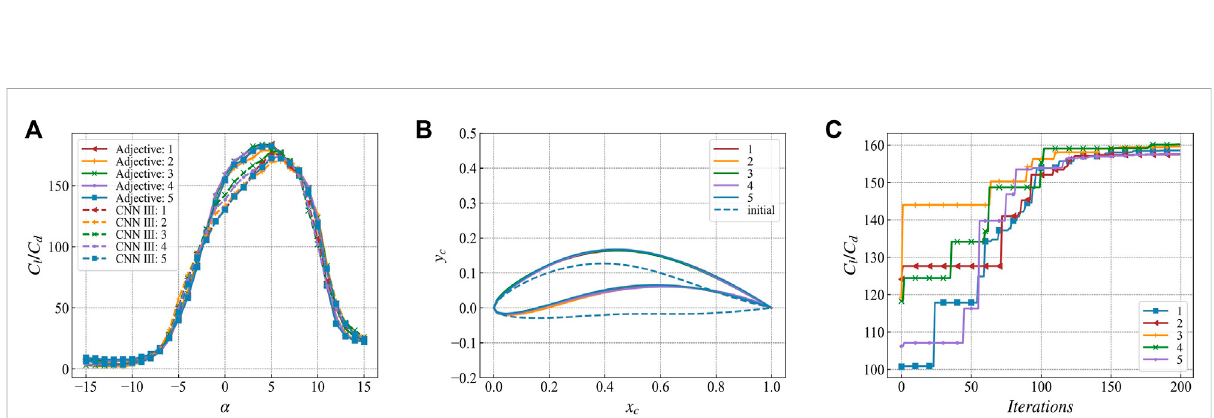
FIGURE 11 TheoptimizationresultofthenumberofionsM=100 (A) Theprediction ofthelift-to-drag ratioofthe fi